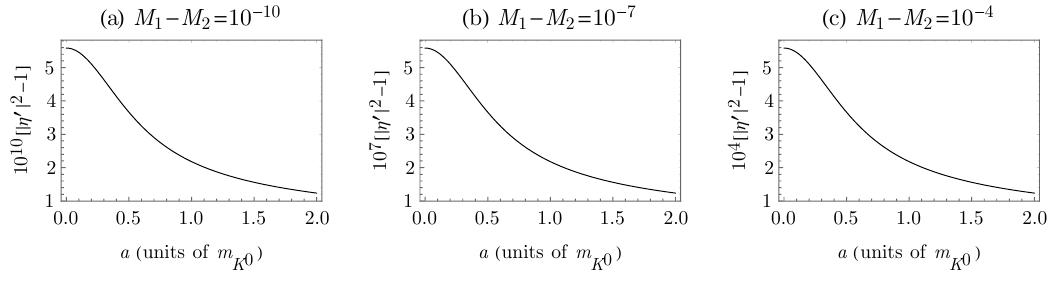
Figure 4 . Plot of | η 0 | 2 − 1 for different values of the mass difference: (a) 10 − 10 m and (c) 10 − 4 m K 0